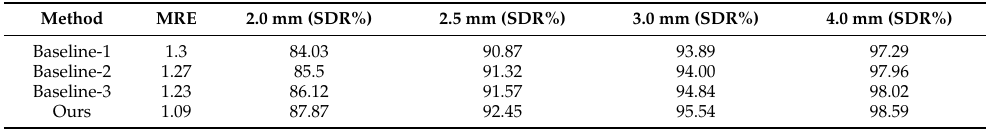
Figure 10. Mean radial errors (unit: 1 mm) in detection of individual landmarks on the ISBI2015 Test (1). Table 3. Ablation study results of Baseline-1, Baseline-2, Baseline-3 and our shooting reward learning in ISBI2015 test set 1 (measured by MRE and SDR).